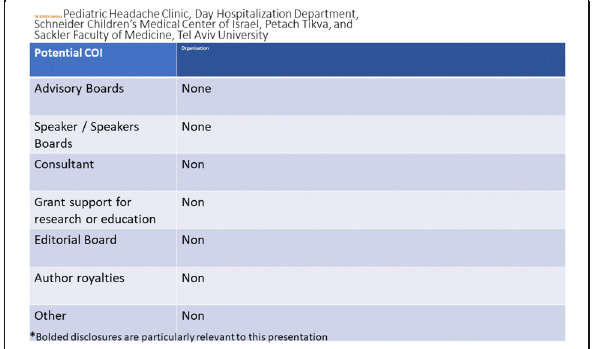
Fig. 1 (abstract P163). See text for description.